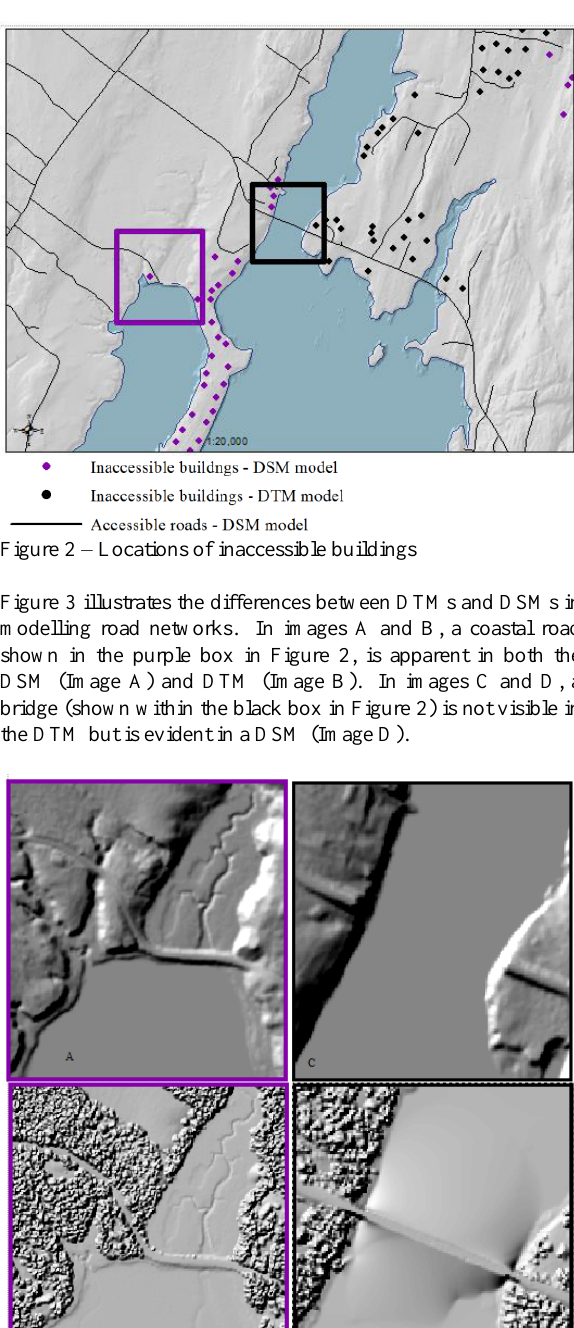
Figure 1 – Inundated roads under Scenarios 1 and 3 A second important dimension of planning for flood events, is identification of structures where coastal residents live who may find themselves unable to evacuate during flood conditions.